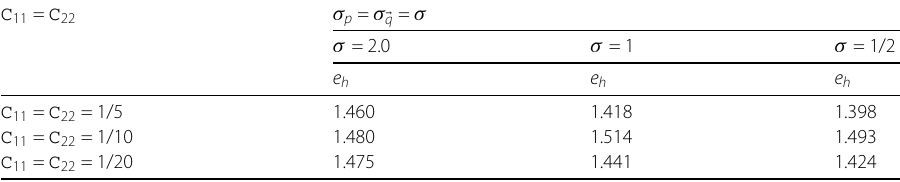
Table 2 Convergence order of the LDG method with (cid:3) C 12 = (1/ C 11 = C